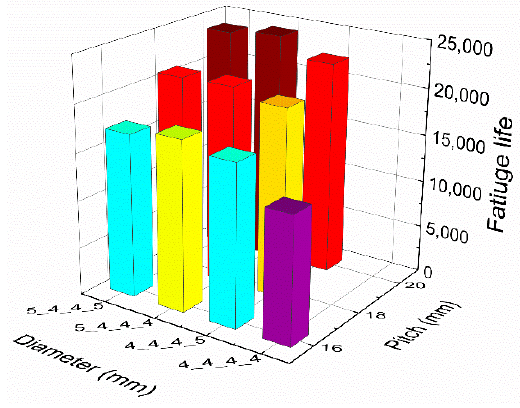
Figure 19. The fatigue lives of the ten groups of riveted lap joints specimens.